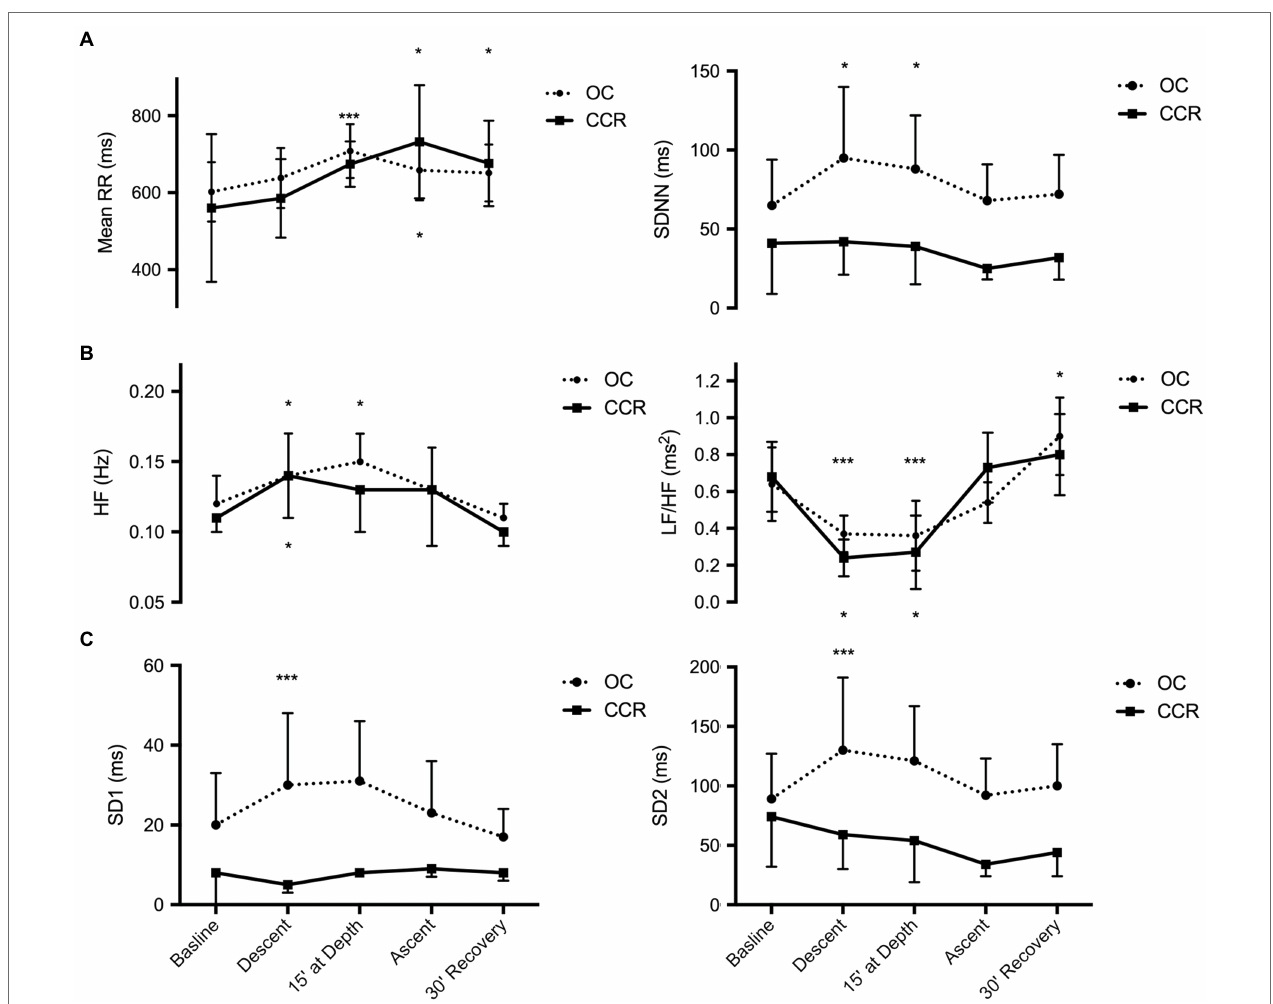
FIGURE 2 | Analysis of heart rate variability. (A) Time-domain analysis; (B) Frequency domain analysis; and (C) Poincare plot. Mean RR, mean RR intervals; SDNN, standard deviation of normal-to-normal intervals; spectral power of HR variability; HF, high frequency and LF/HF, low frequency to high frequency ratio; SD1, beat- to-beat HR variability; and SD2, global HR variability. * p < 0.05; and *** p <